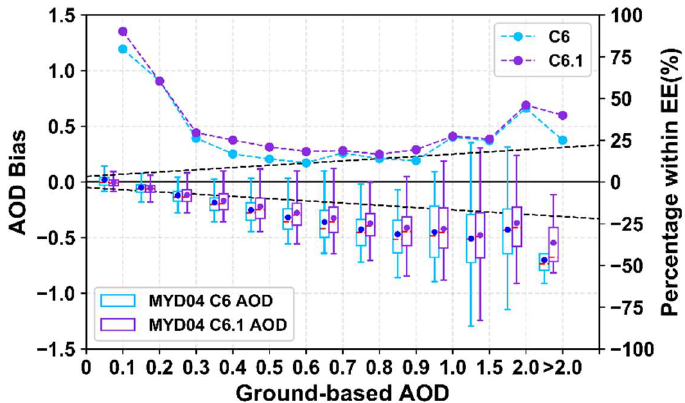
Figure 4. Box plots of AOD bias (MODIS AOD—Ground-based AOD) and the percentage of retrievals falling within the EE envelopes (dashed curves) for MYD04 C6 and C6.1 DB AOD against ground-based AOD measurements at 0.55 μm as a function of aerosol loading. Cyan and purple represent the results of C6 and C6.1, respectively. The black horizontal solid line represents the zero bias. The two black dashed curves represent the EE envelopes: ±(0.05 + 20%AOD ground ). In each box, the middle, lower, and upper horizontal lines represent the AOD bias median, and 25th and 75th percentiles, respectively.